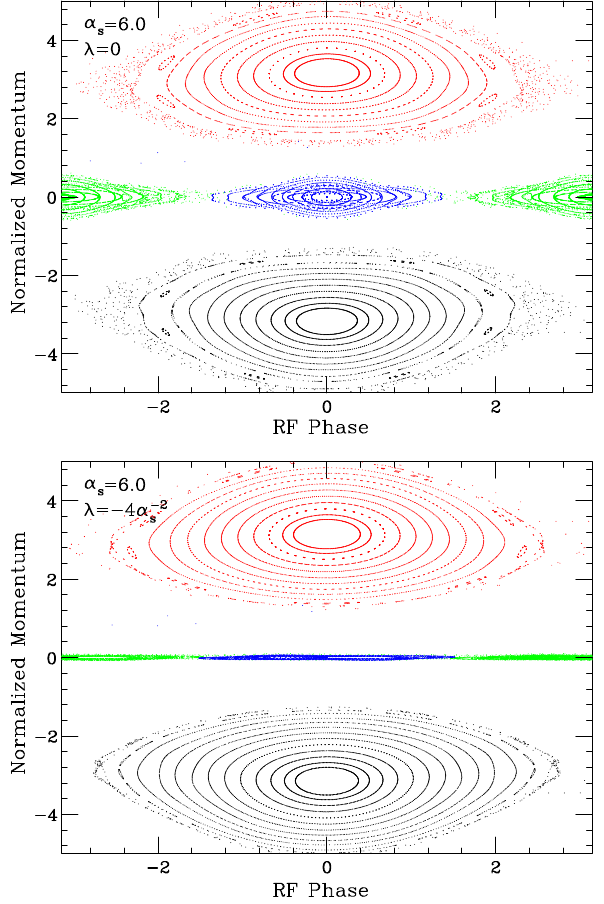
FIG. 4. Phase-space structure with slip-stacking parameter α ¼ 6 . 0 is shown in the top plot with no second-harmonic rf s compensation or λ ¼ 0 , and in the lower plot with second- harmonic rf compensation or λ ¼ − 4 = α 2 s ¼ − 0 . 111 . It is clear that the compensation reduces the chaotic region between the upper and lower buckets with, however, only small increase in the phase-space areas of the slip-stacking